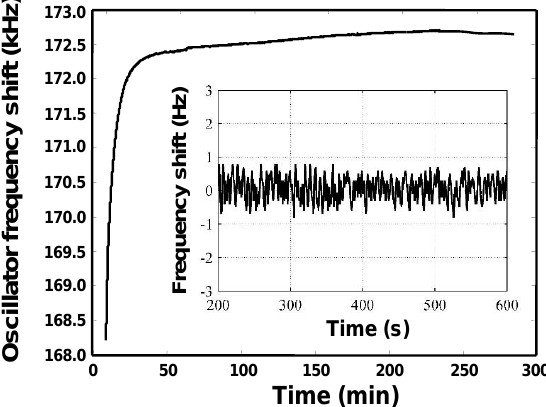
Figure 10. Frequency stability test of the proposed sensor system.